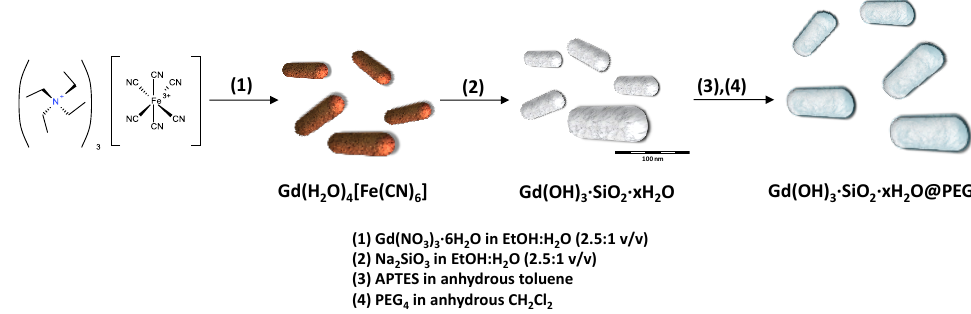
Table 1. Compositional and textural characteristics of as-synthesized materials.